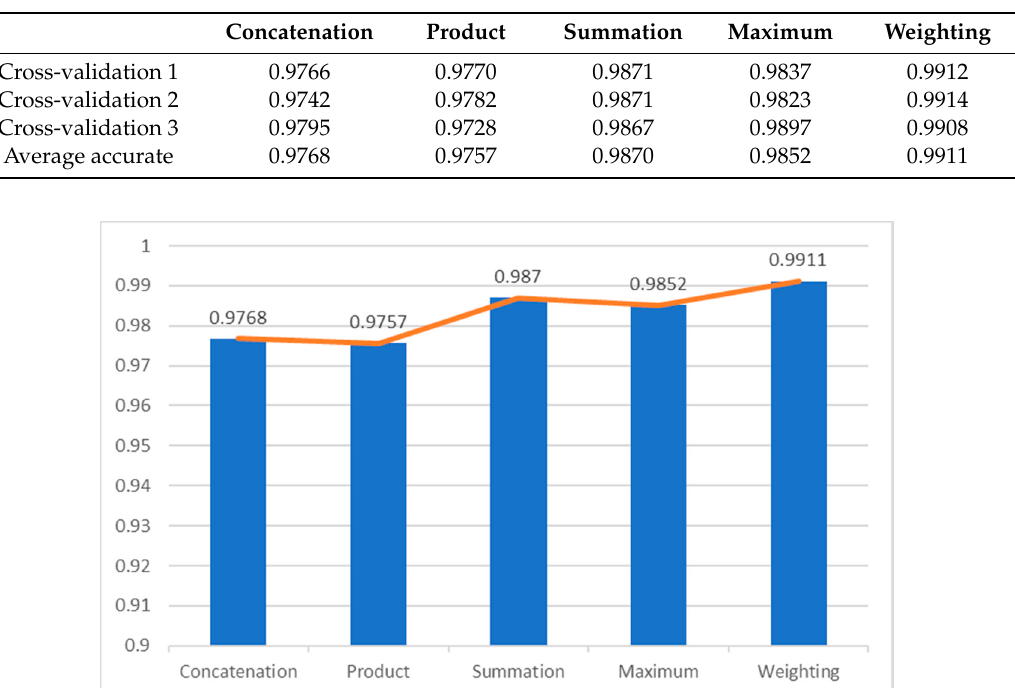
Figure 4. The average accuracy using various feature fusion methods.